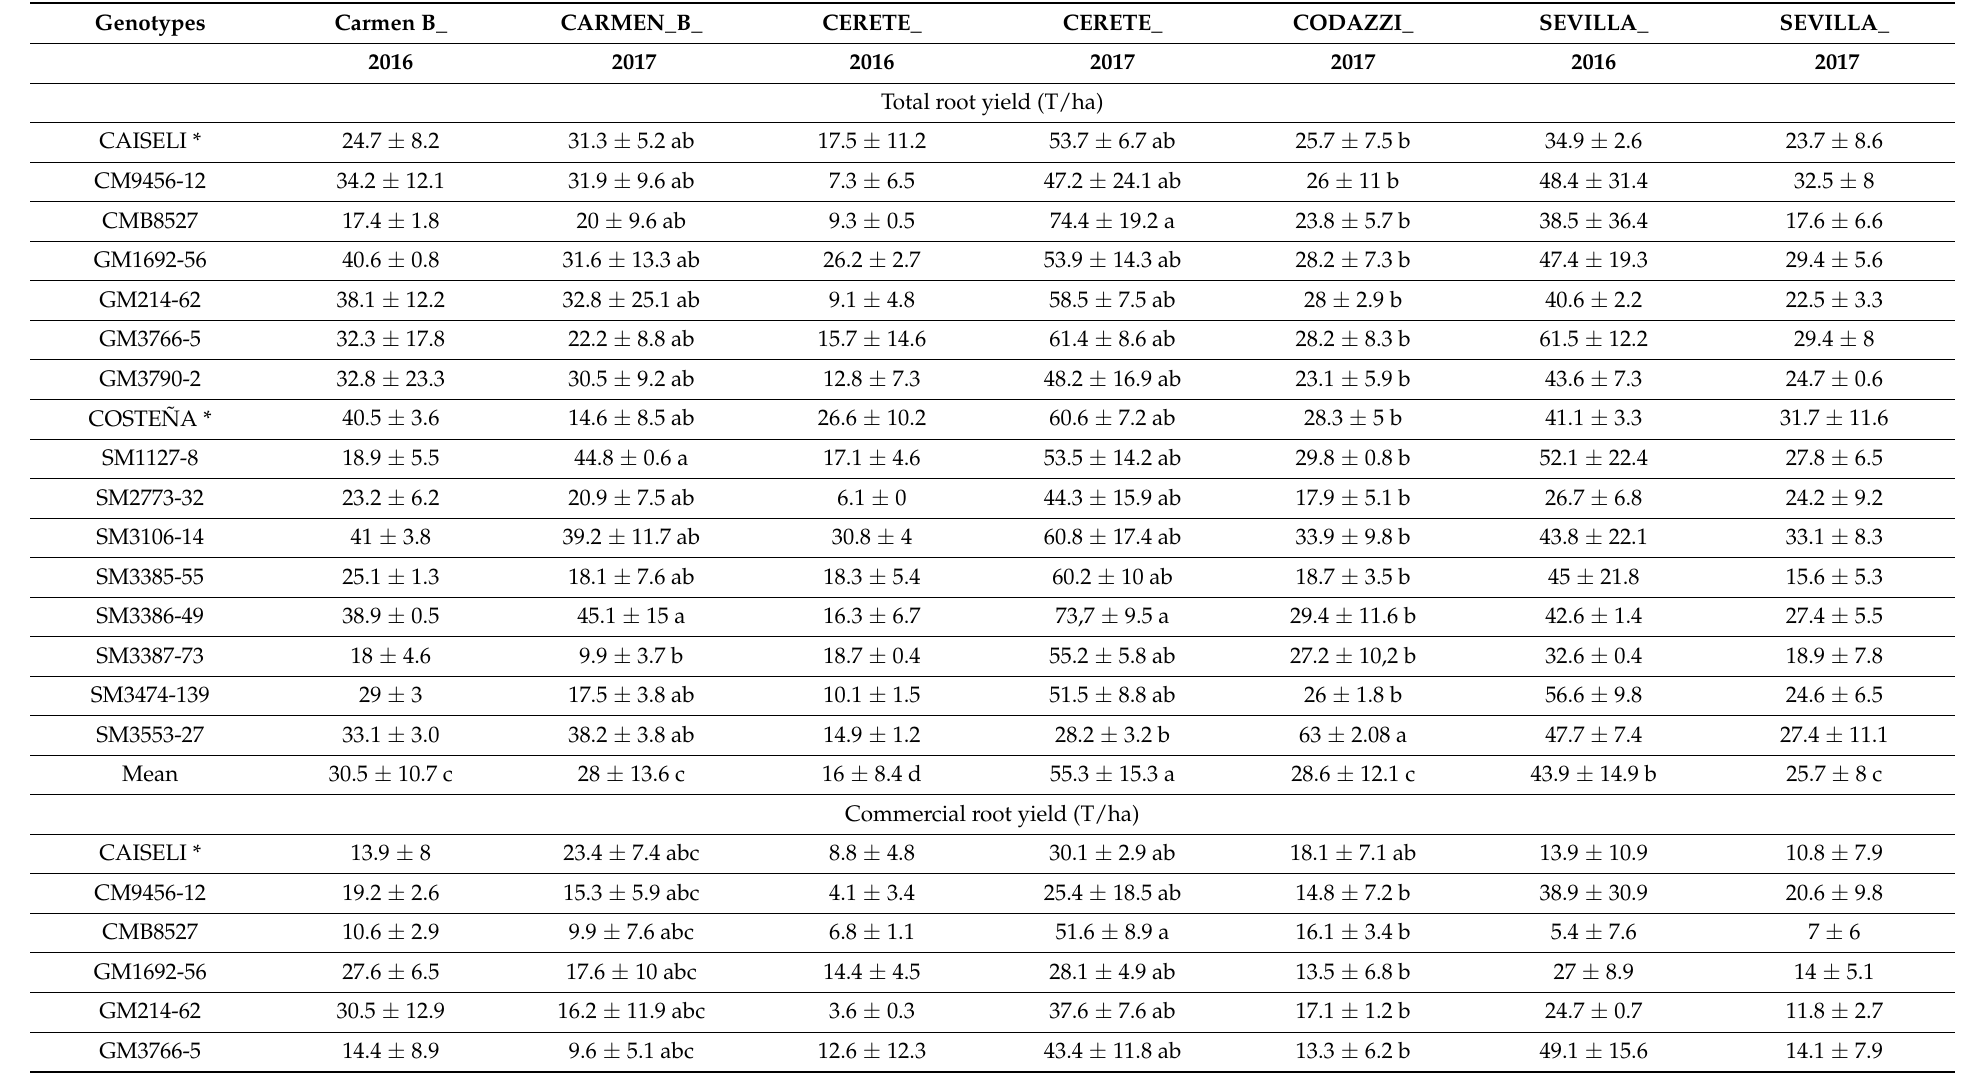
Table 4. Average and standard error values for total root yield, commercial root yield and dry matter content for the 16 genotypes assessed per location and production cycle.